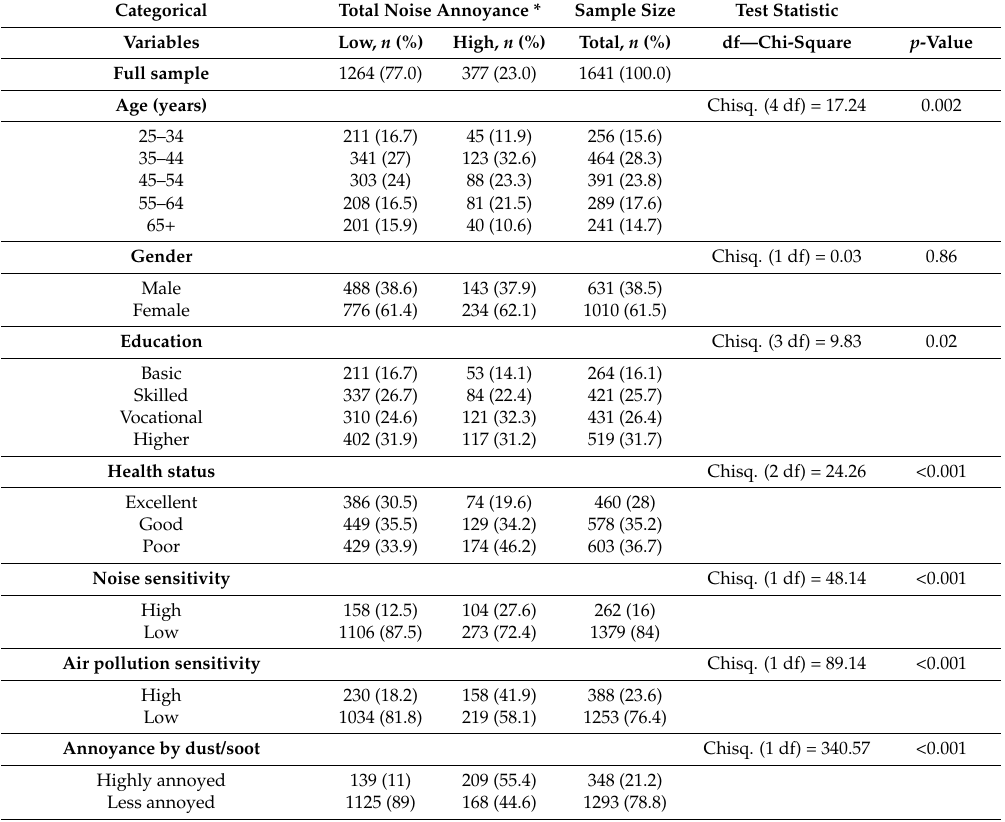
Table 1. Description of categorical variables in the various models broken down by total highly annoyed. Categorical Total Noise Annoyance * Sample Size Test